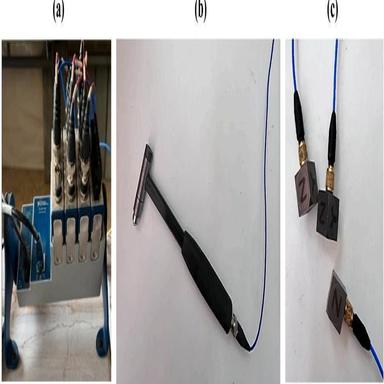
The mechanical materials used for modal analysis, (a) M + P International Analyzer of 9234 acquisition card and (b) Hammer (PCB 086C03), and (c) Accelerometers (356A15).